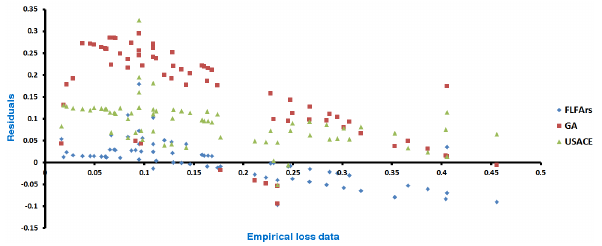
Figure 14. Residual plot used for comparing the performance of selected damage functions relative to empirical loss